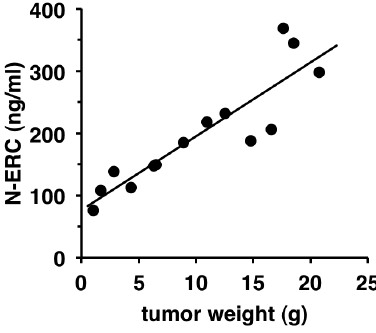
Figure 4. Correlation between tumor weight and serum level of N-ERC/mesothelin. The serum level of N-ERC/mesothelin in homo- zygous Kras301 rats bearing pancreas ductal carcinomas. The serum level of N-ERC/mesothelin correlated with increased tumor weight (R=0.897).